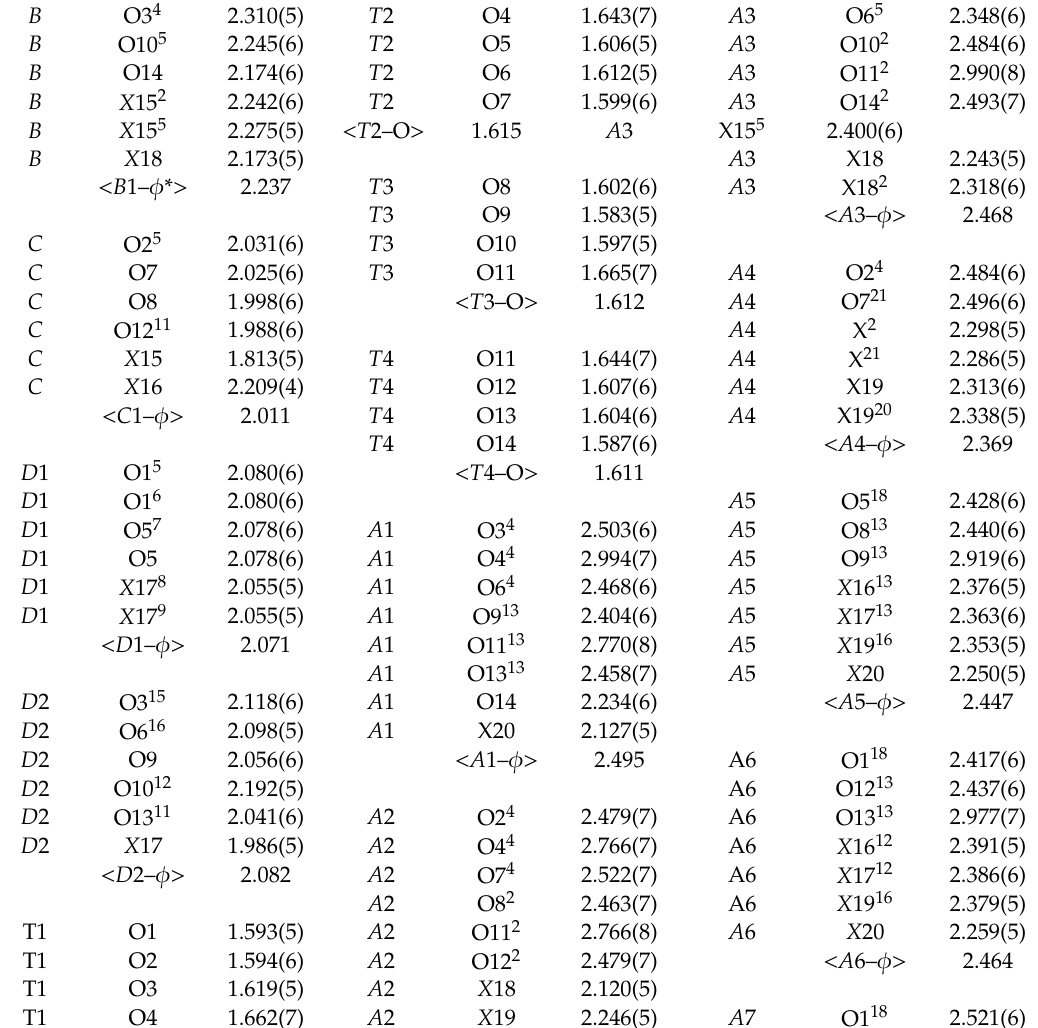
Table 7. Selected interatomic distances (Å) for the crystal structure of